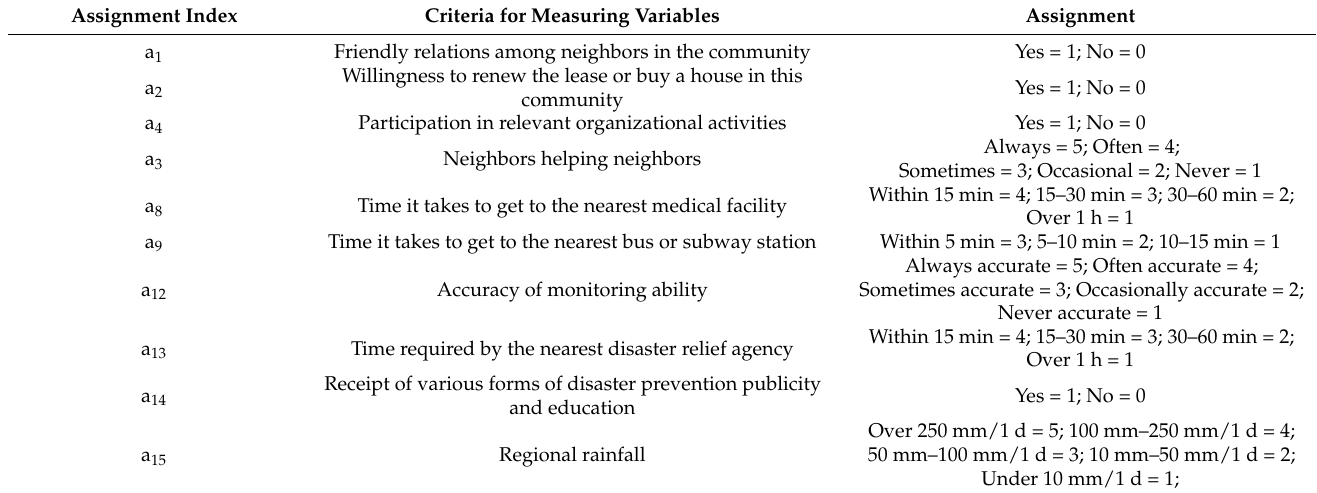
Table 7. Assigning methods.